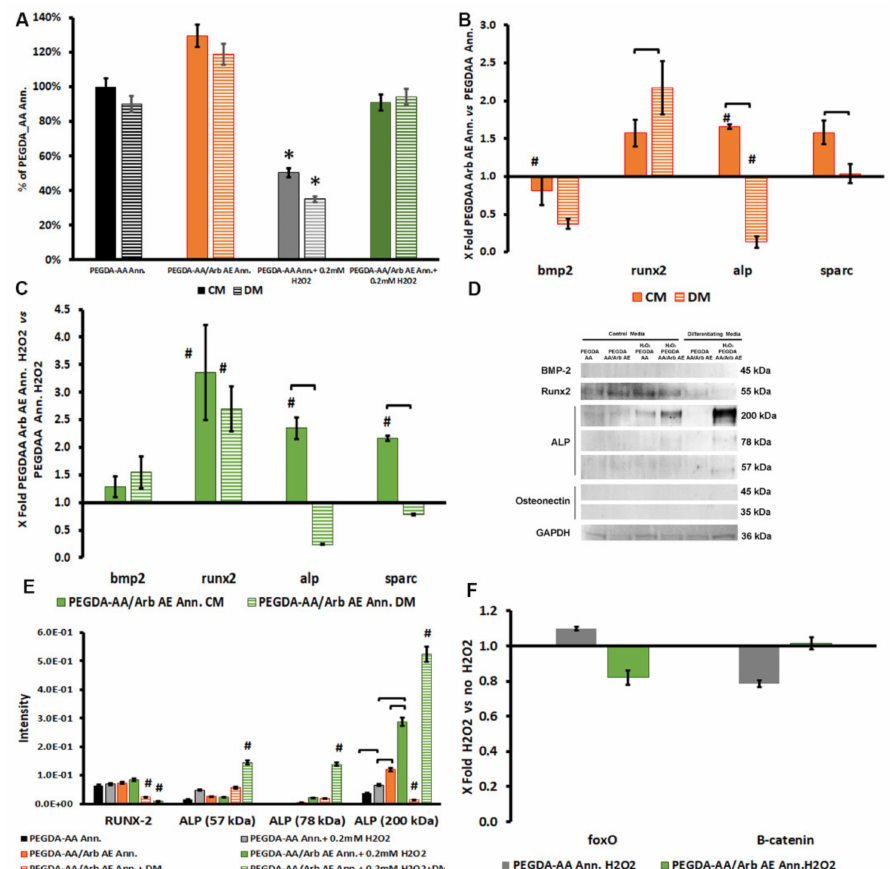
Figure 8. ( A ) MTT viability of PDPCs cultured on PEGDA-AA Ann. and PEGDA-AA / Arb AE Ann. and exposed to oxidative stress for up to 7 days of culture. Data are expressed as a percentage of PEGDA-AA Ann.; * p < 0.05 vs. all conditions. ( B ) Histogram depicting changes in bmp2, runx-2, alp and sparc mRNAs in PDPCs on PEGDA-AA / Arb AE Ann. cultured in complete (CM) or di ff erentiating (DM) medium for 7 days. Data are expressed as fold change (2 − ∆∆ Ct ) over PEGDA-AA Ann. The axes intersect at 1, which indicates the range of mRNA expression in cells cultured on PEGDA-AA Ann. ( C ) Histogram depicting changes in bmp2, runx-2, alp and sparc mRNAs in PDPCs on PEGDA-AA / Arb AE Ann. cultured in complete (CM) or di ff erentiating (DM) medium both in the presence of H 2 O 2 for 7 days. Data are expressed as fold change (2 − ∆∆ Ct ) over PEGDA-AA Ann. in the presence of H 2 O 2 . The axes intersect at 1, which indicates the range of mRNA expression in untreated cells; # indicates significant di ff erences ( p < 0.05) in comparison to controls without arbutin and square brackets indicate significant di ff erences between cells cultured in CM and DM. ( D ) Western blot analysis protein expression. ( E ) Histograms depicting the densitometric quantitation of RUNX-2 and ALP of the blots presented in D. Since BMP-2 and ON were not expressed, they were not considered for the histogram. ( F ) FoxO and β -catenin variations in PEGDA-AA Ann. and PEGDA-AA / Arb AE Ann. in cells undergoing stress induction. Data are expressed as fold change (2 − ∆∆ Ct ) of H 2 O 2 untreated cells; the axes intersect at 1, which indicates the range of mRNA expression in untreated